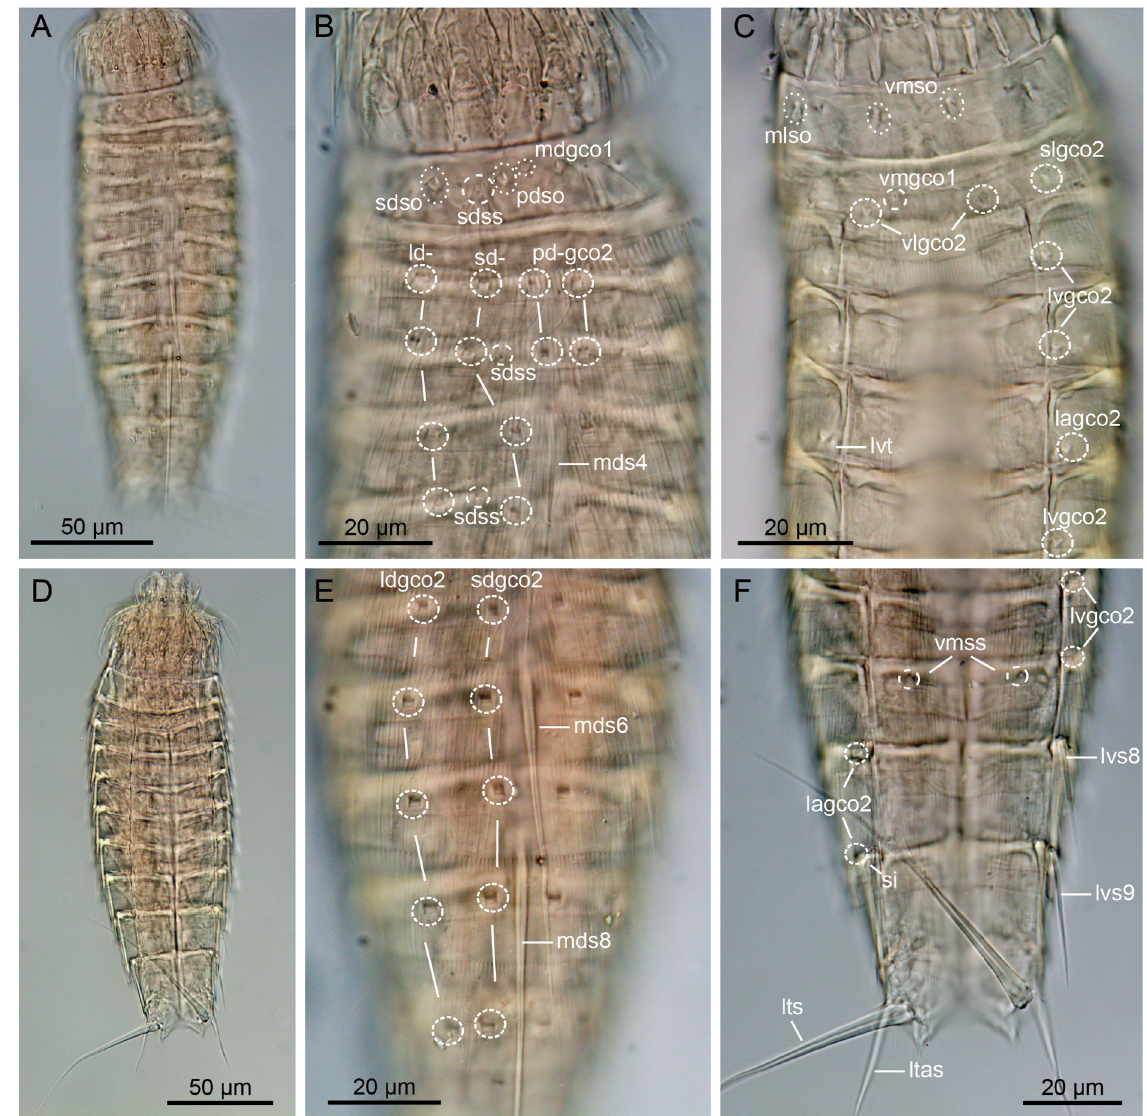
Fig. 27. Light micrographs showing overview and details of Echinoderes aragorni sp. nov. A–B, D–F . ♀, holotype (NIWA-159423). C . ♀, paratype (NIWA-159424). A . Dorsal overview. B . Segments 1 to 6, dorsal view. C . Segments 1 to 6, ventral view. D . Ventral overview. E . Segments 5 to 9, dorsal view. F . Segments 7 to 11, ventral view. Abbreviations: see Material